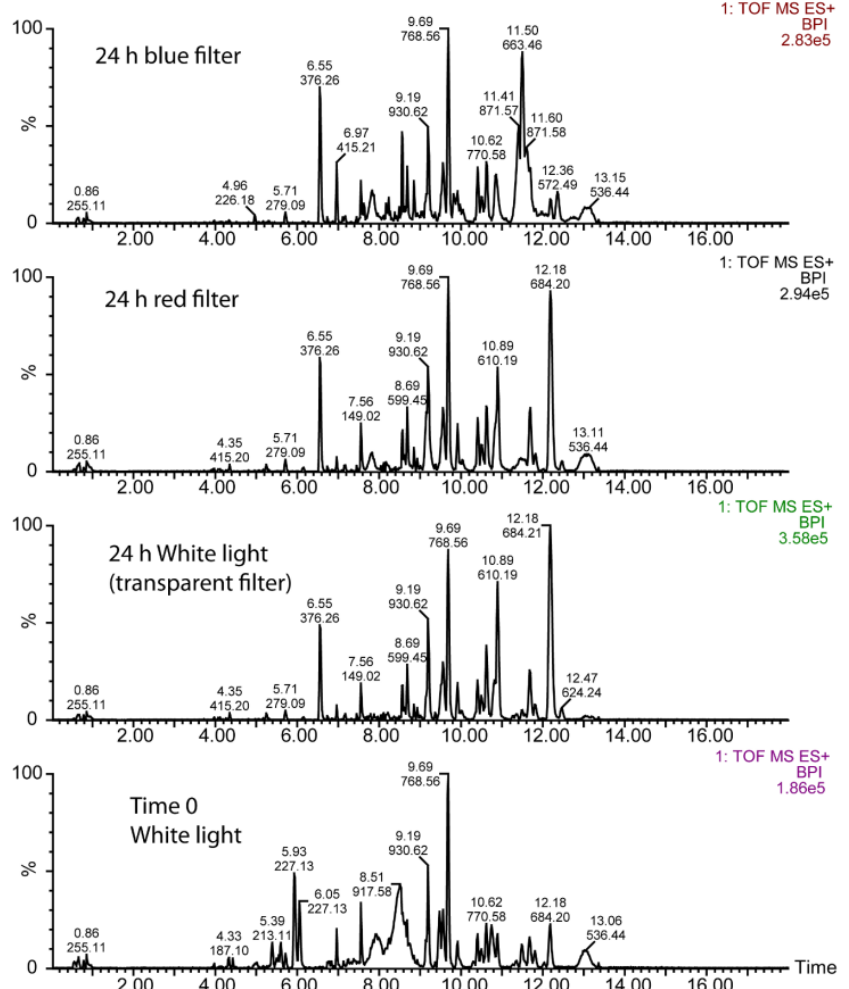
Figure 1. Typical base peak intensity (BPI) chromatograms obtained for the methanolic extract after UPLC-MS analysis of the culture covered with a blue filter for 24 h (upper panel), the culture covered with a red filter for 24 h (second panel down from top), the culture covered with a transparent filter for 24 h (second panel up from bottom), and the stock culture grown under white light and used for the inoculum of the transparent, red and blue filter cultures (lower panel). The numbers above each chromatographic peak indicates the retention time (up) and the m/z predominating in that peak (down). Right legends: 1. TOF MS ES+, MS with electrospray positive ionization; BPI, base peak intensity; number, intensity to which 100% is fitted.